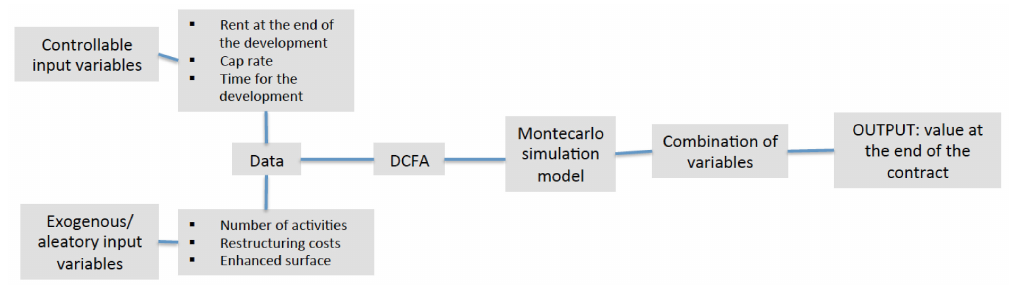
Figure 1. Methodology for the appraisal of Factory Grisù.